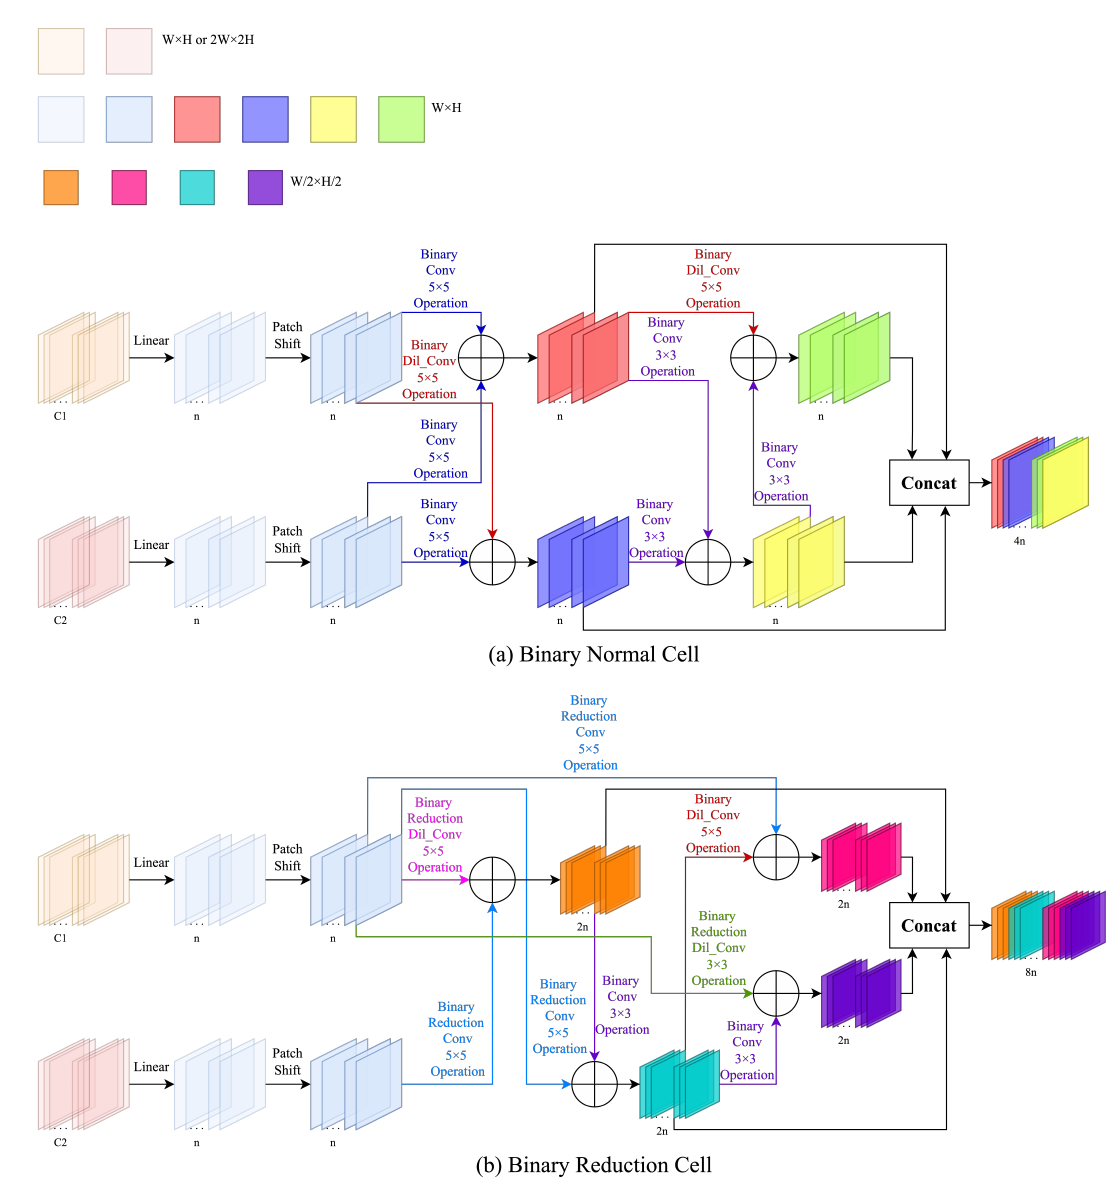
Figure 2. The architectures of the cells in